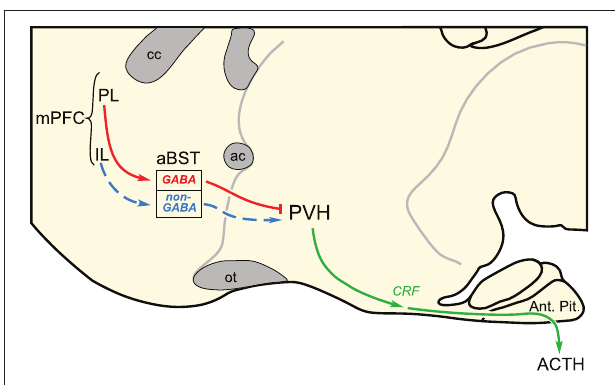
FIGURE 3 | Two disynaptic pathways from medial prefrontal cortex (mPFC) are proposed to account for the differential modulation of emotional stress-induced HPA output. Whereas evidence highlighted in the text [see also, Radley et al. (2009)] supports GABAergic neurons in the anterior bed nuclei of the stria terminalis (aBST) as interceding for the HPA-inhibitory influences of prelimbic cortex (PL; red lines), the pathway from infralimbic cortex (IL) is suggested, and remains to be verified with functional studies. ac, anterior commissure; ACTH, adrenocorticotropic hormone; Ant. Pit., anterior pituitary gland; cc, corpus callosum; CRF, corticotropin-releasing factor; ot, optic tract; PVH, paraventricular nucleus of the